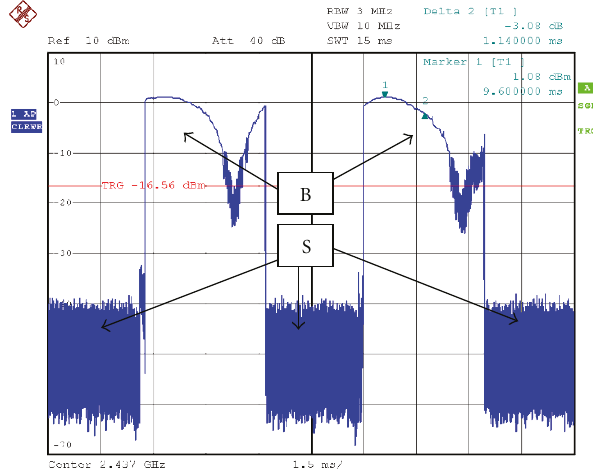
Figure 12: A bigger frequency di ff erence of source nodes leads to a shorter beamforming coherent collaborative